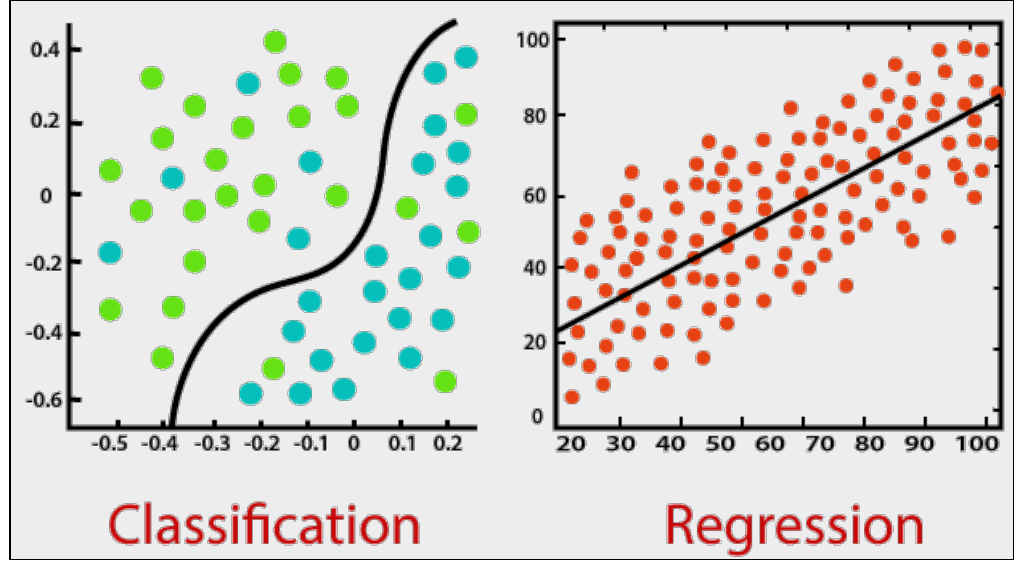
Figure 2: Classification X